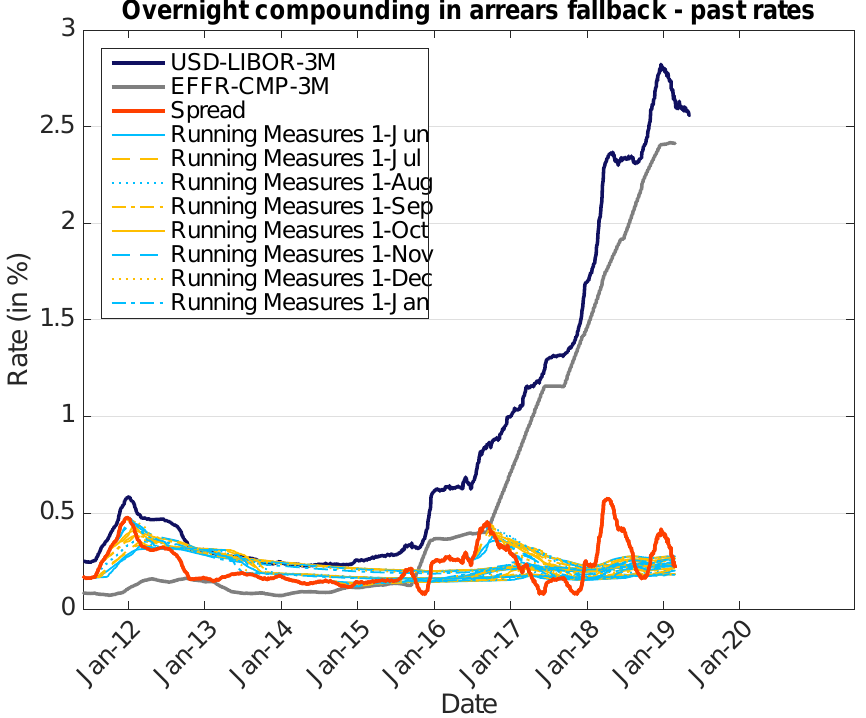
Figure 4. Historical time series for USD-LIBOR-3M and EFFR compounded on three-month periods. Running mean and median are for 5-, 7 -and 10-year look back periods and different announcement